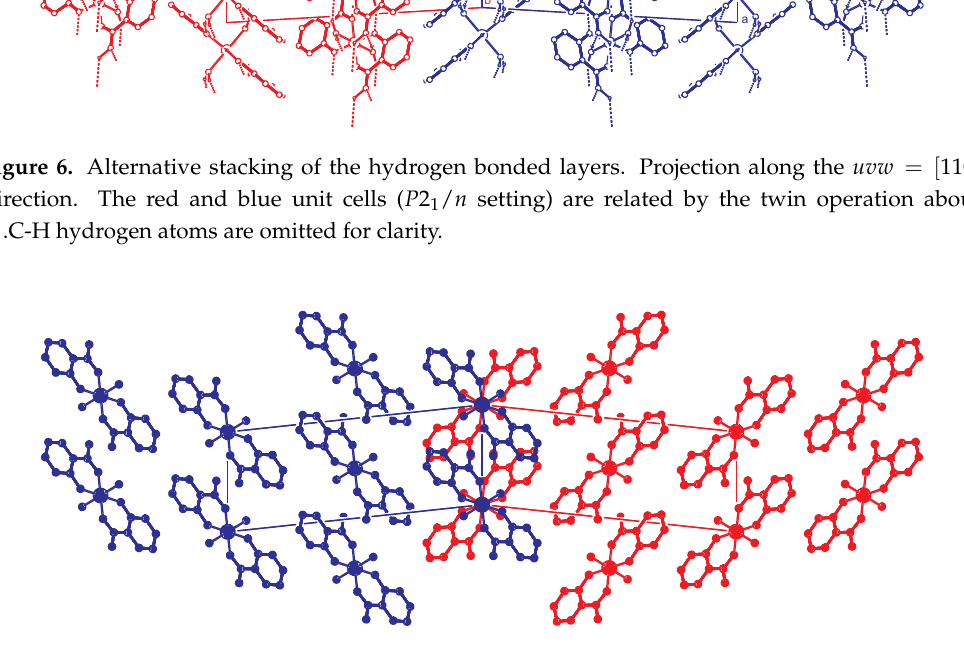
Figure 7. View on the twinned structure along the uvw = [ 010 ] direction ( P 2 1 / n setting). The second unit cell is generated by the twin operation about a . At the twin boundary, both components are drawn. The blue molecules are related to the red molecules by an approximate operation x + 1/2, y + 1/2, 1/2 − z . This operation is not part of the P 2 1 / n space group but is obtained by a combination of the n -glide x + 1/2, 1/2 − y , z + 1/2 and the twin operation (rotation) about a : x , − y , − z . Hydrogen atoms are omitted for clarity.